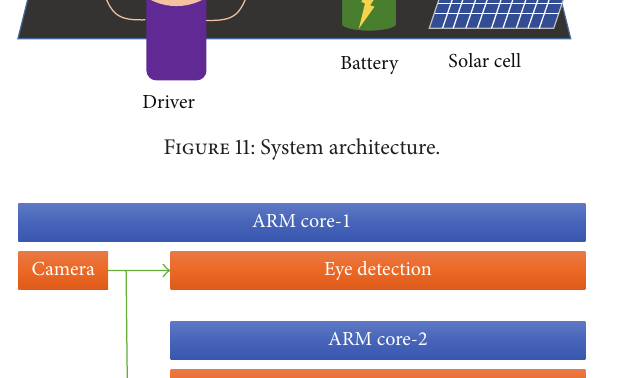
Figure 12: Task dispatches of the proposed system on the multicore platform.